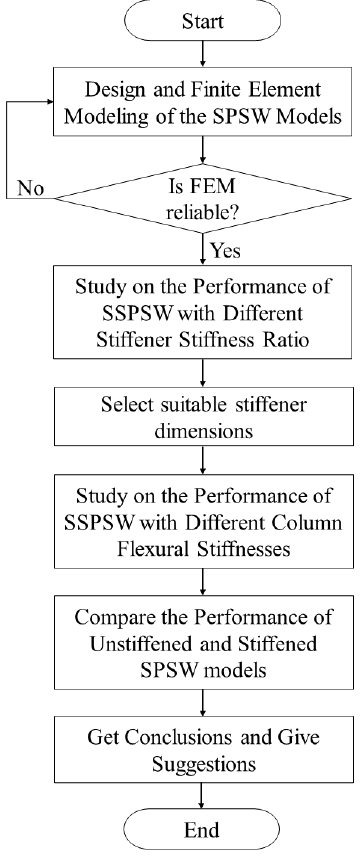
Figure 2. Flow chart of the argument logic of this article.